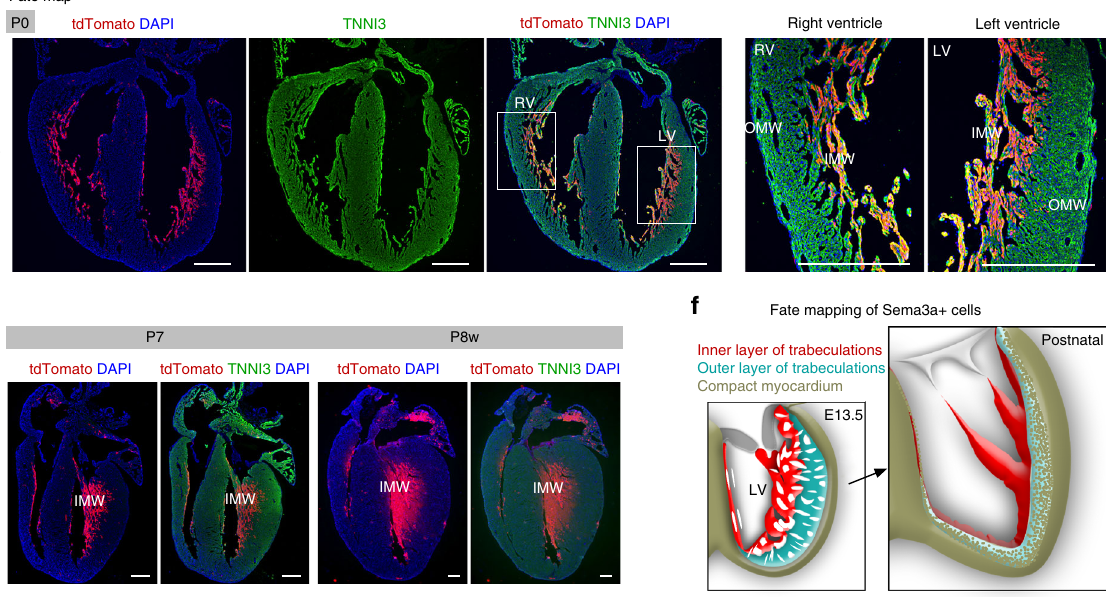
is not complete in all Hey2 + cardiomyocytes in our study. Examination of trabecular marker connexin 40 (Cx40) or compact marker Hey2 on the mutant heart section, however, showed that the trabecular or compact myocardial identity remains similar in the mutants compared with the controls (Supplementary Fig. 9). Echocardiography of adult mutant and control hearts showed a signi fi cant reduction of ejection fraction (EF) and fractional shortening (FS) in the mutant hearts compared with the controls (EF: 69.66 ± 5.56 vs. 39.60 ± 12.55%; FS: 39.12 ± 4.86 vs. 19.71 ± 6.45%; respectively, Fig. 9f), indicat- ing reduction of heart function in the mutants. Taken together, these data indicate that expansion of Hey2 + cardiomyocytes is essential for formation of the hybrid myocardial zone (Fig. 9g).